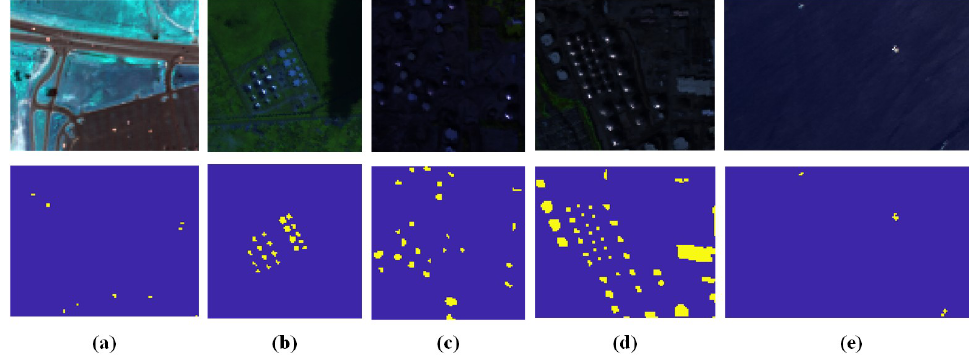
Figure 3. Pseudo-color images and ground truth for ( a ) HYDICE, ( b ) ABU-urban1, ( c ) ABU-urban2, ( d ) EI Segundo, and ( e ) Grand